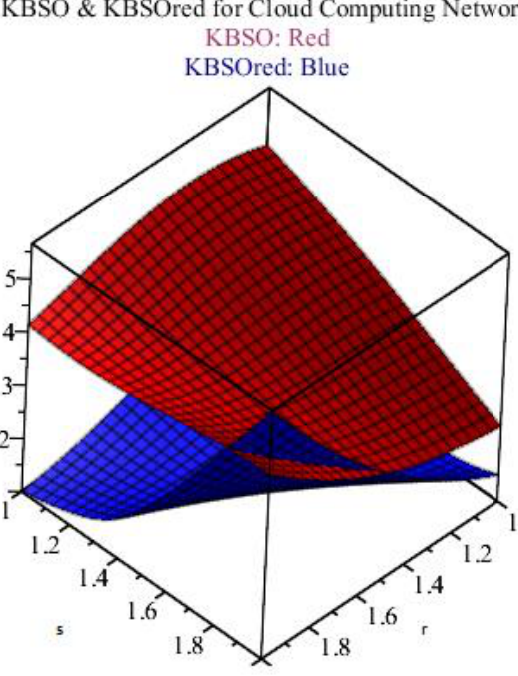
Figure 4. Results of KBSO and KBSO red invariants for cloud computing network.